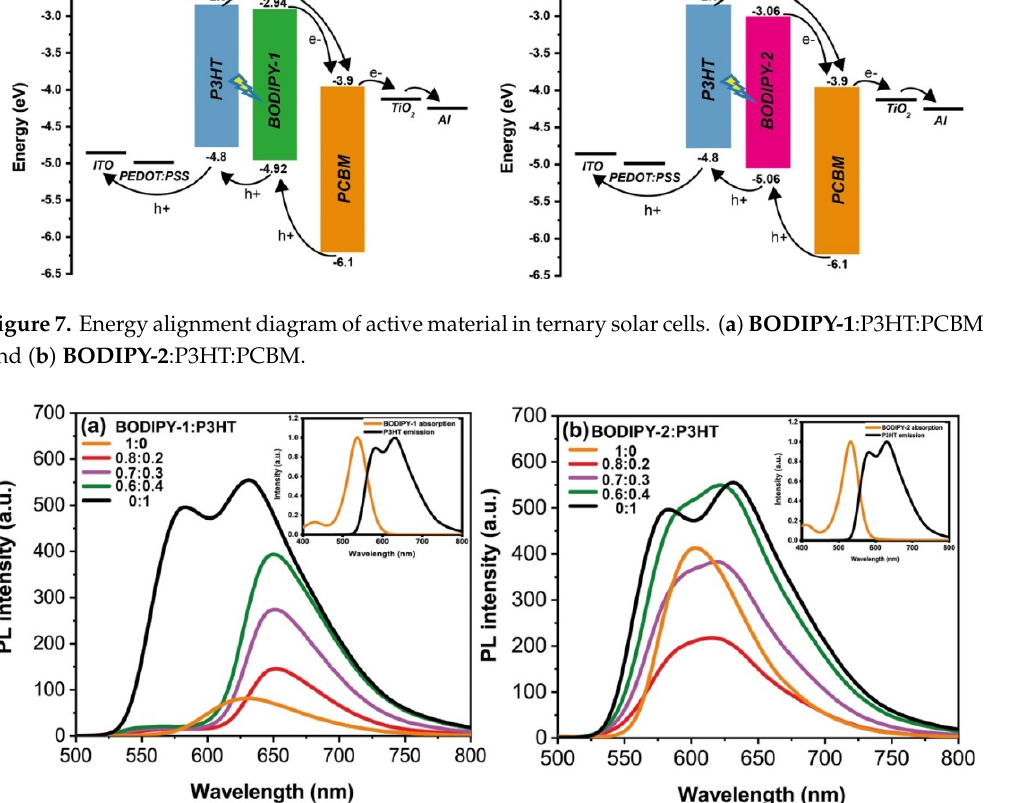
Figure S1: 1 H-NMR of 2,6-diiodo-BODIPY, Figure S2: 13 C-NMR of 2,6-diiodo-BODIPY, Figure S3: 1 H-NMR of TPA-BODIPY-TPA ( BODIPY-1 ), Figure S4: 13 C-NMR of TPA-BODIPY-TPA ( BODIPY-1 ), Figure S5: 1 H-NMR of CBZ-BODIPY-CBZ ( BODIPY-2 ), Figure S6: 13 C-NMR of CBZ-BODIPY-CBZ, Figure S7: TGA of BODIPY-1 and BODIPY-2 , Table S1: Performance parameters of ternary solar cells with BODIPY:P3HT:PCBM (P3HT concentration was higher than BODIPY), Table S2: Parameters fitted from the Nyquist plot of binary solar cells and ternary solar cells. Table S3: Contact Angle measurement of P3HT, BODIPY-1 , BODIPY-2 and PCBM,